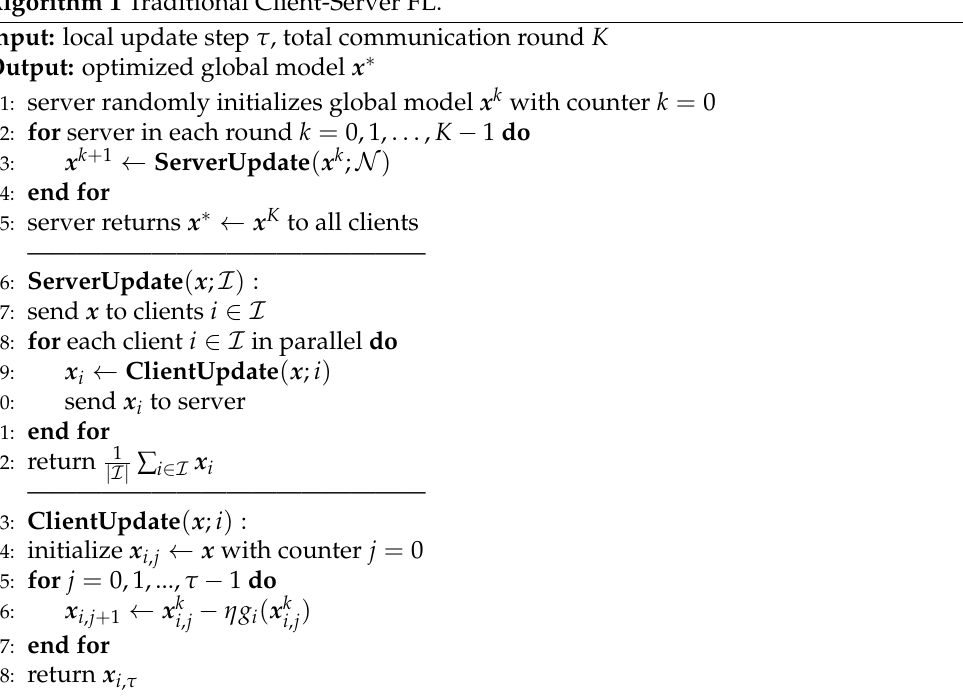
Algorithm 1 Traditional Client-Server